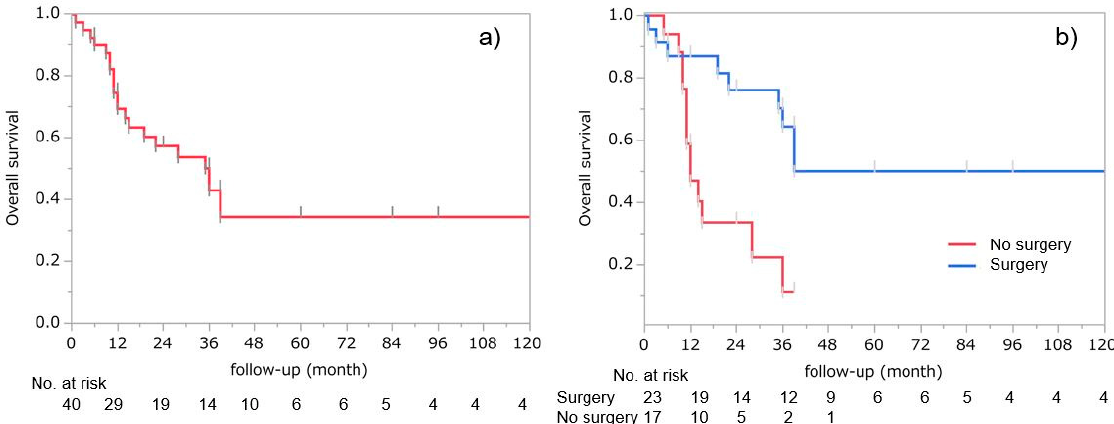
Figure 2. ( a ) Two-year survival rates were 57.4%, and 5-year survival rate was 34.4% in 40 cases. ( b ) Among the 30 patients whose EBV status and prognosis were stated, the 2-year survival rate was 36.0% for positive cases and 58.3% for negative cases; however, the difference was not significant.